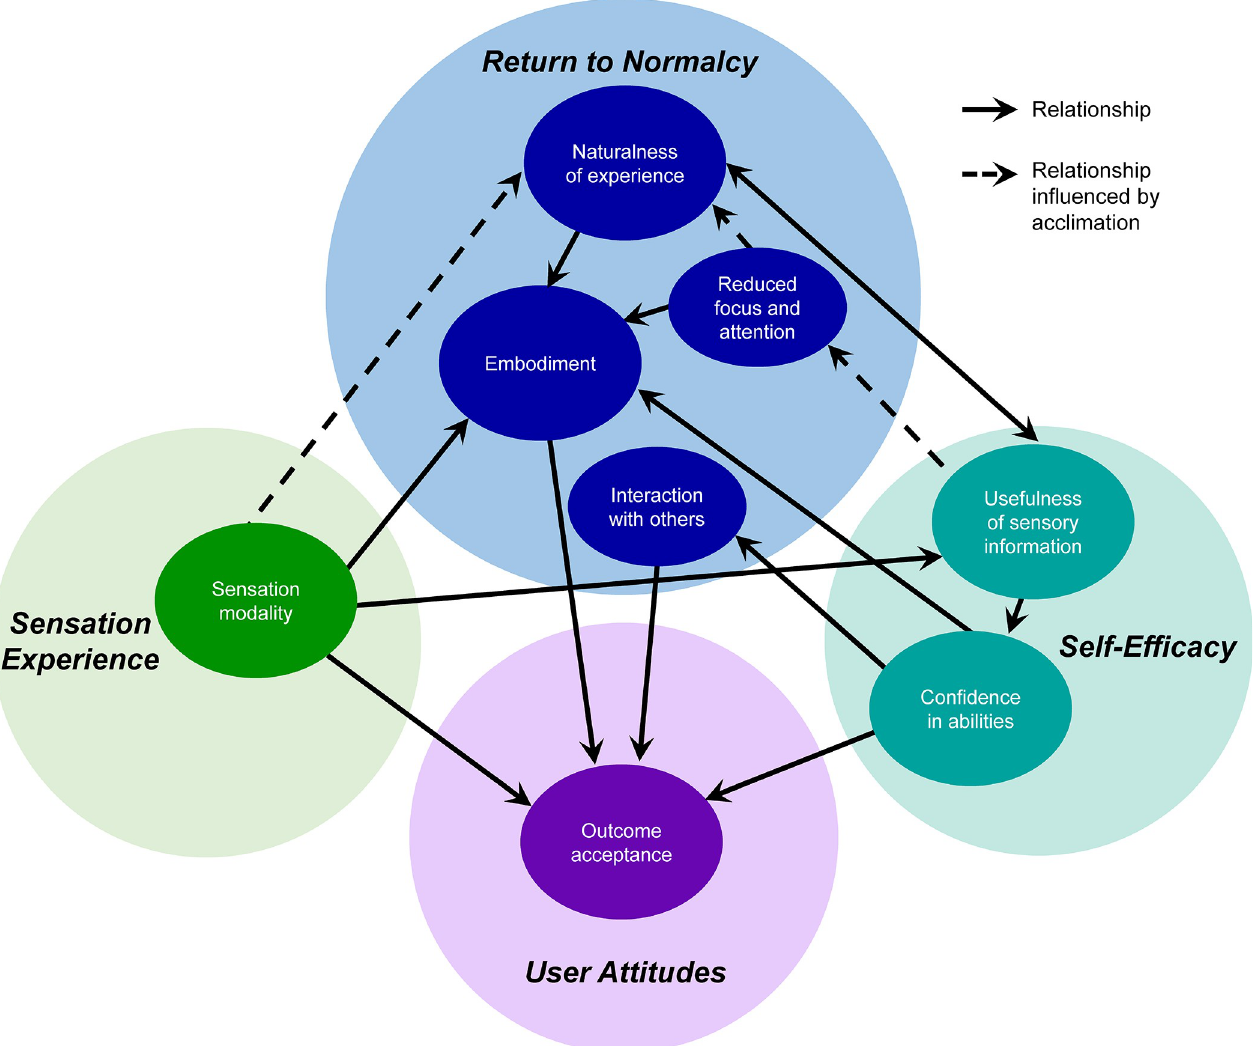
Fig 2. Model of the benefits of sensation on the experience of a hand. Concept categories are indicated by color. Solid arrows indicate directional relationships between concepts. Dashed arrows indicate relationships that are influenced by acclimation and thus strengthen over time.